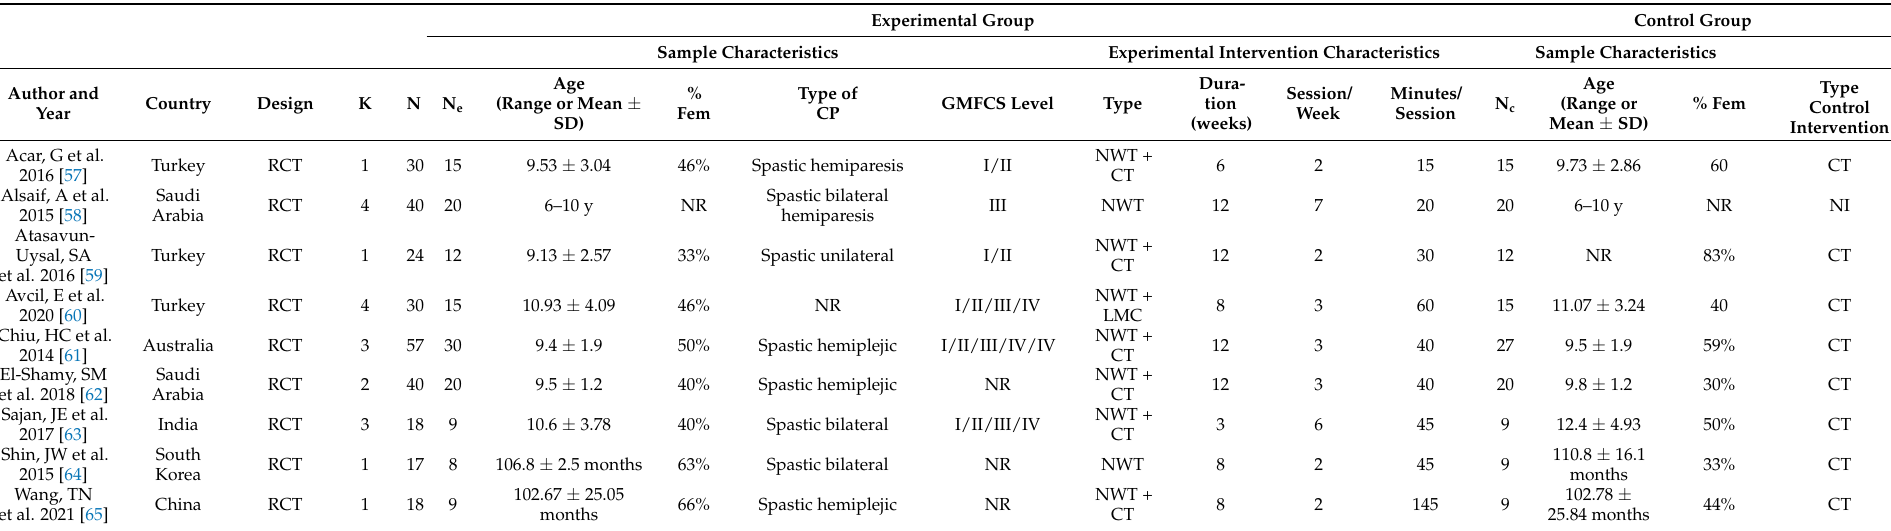
Table 3. Characteristics of the studies included in the